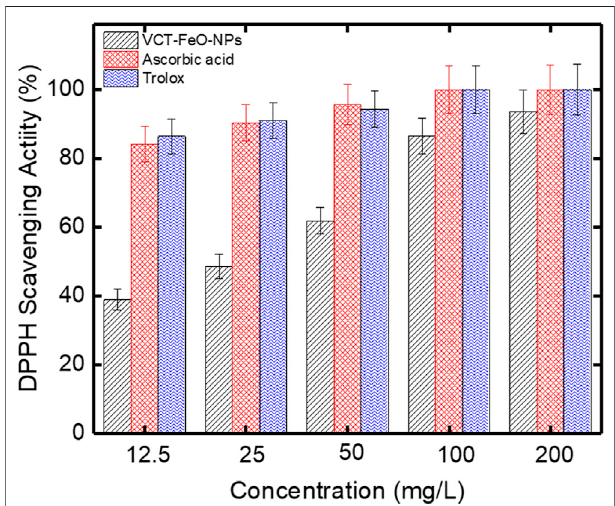
FIGURE 5 | DPPH scavenging activity.